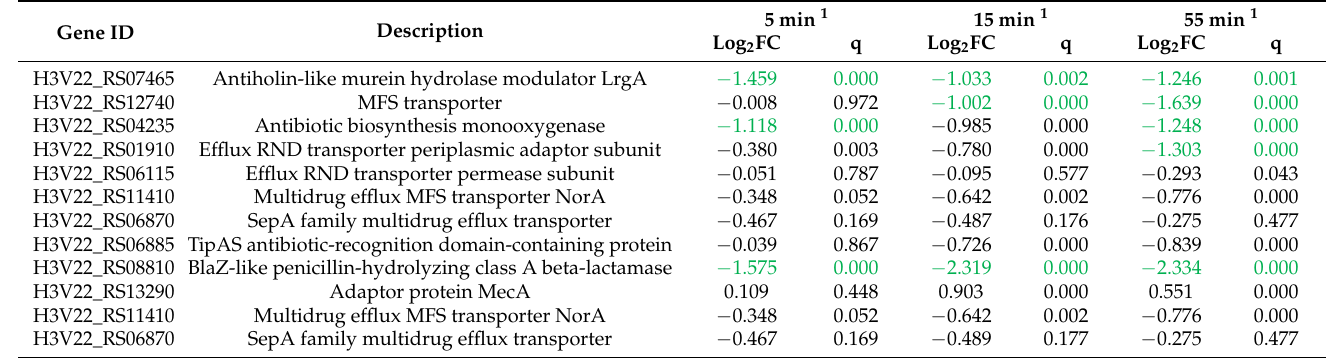
Table 4. Transcript levels of host drug resistance-related genes during phage SA1 infection.